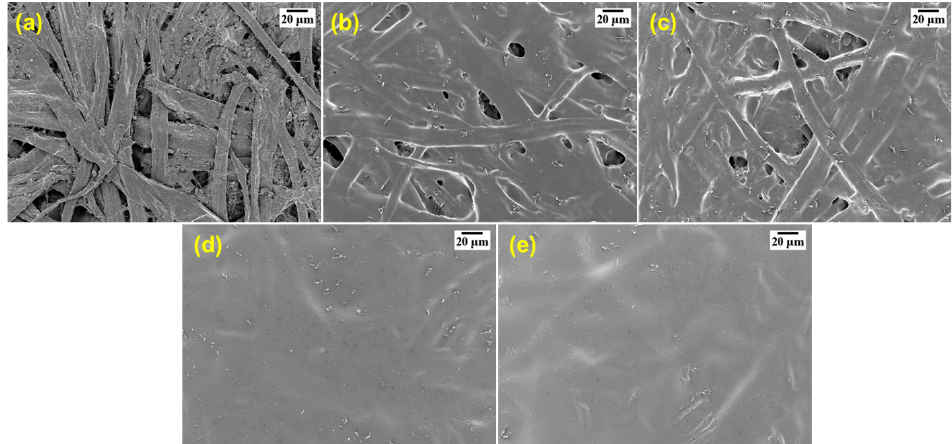
Figure 4. FE-SEM images of ( a ) the base paper, ( b ) PVA/AKD-S coated paper, ( c ) PVA/AKD/5% nanoclay-S coated paper, ( d ) PVA/AKD-D coated paper, and ( e ) PVA/AKD/5% nanoclay-D coated paper. S: single coating; D: double coating. Table 3. Coat weights of the papers.